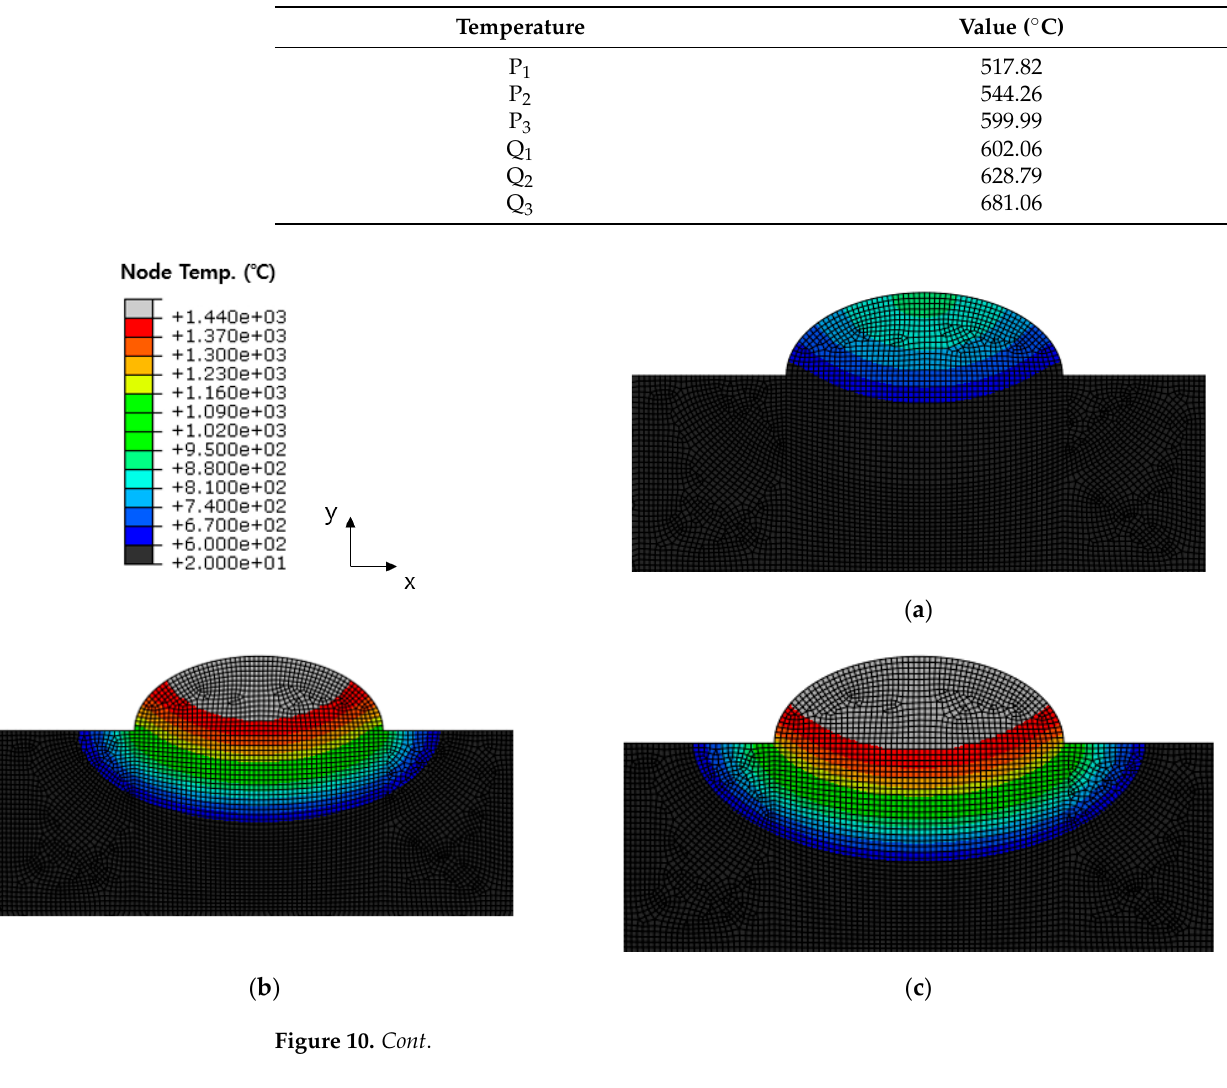
Table 7. Maximum temperature at each checkpoint per welding condition.